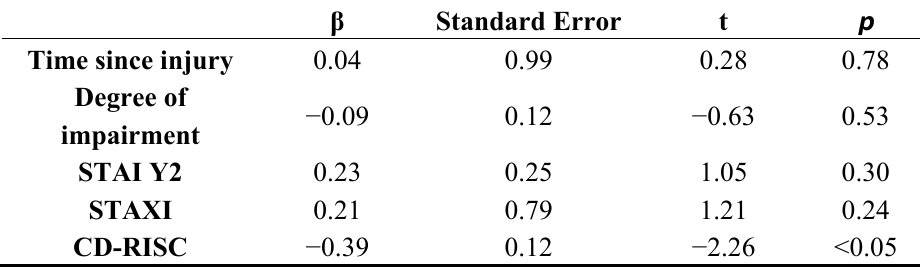
Table 4. Block multiple linear regression analysis (injured group). Dependent variable: PSS Total. Predictors: accident-related features (time since injury, degree of impairment) and psychological variables (STAI Y2, STAXI,